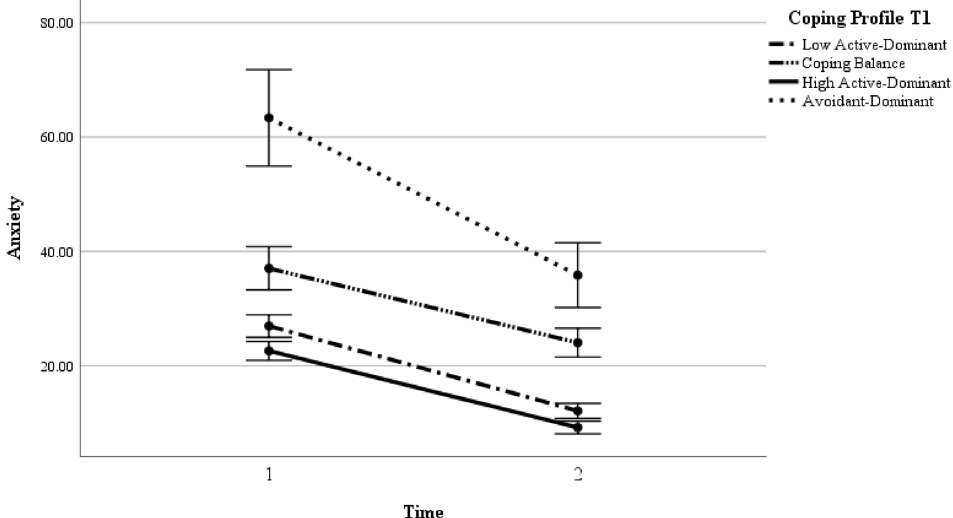
Figure 2. Anxiety across the two times and as a function of coping